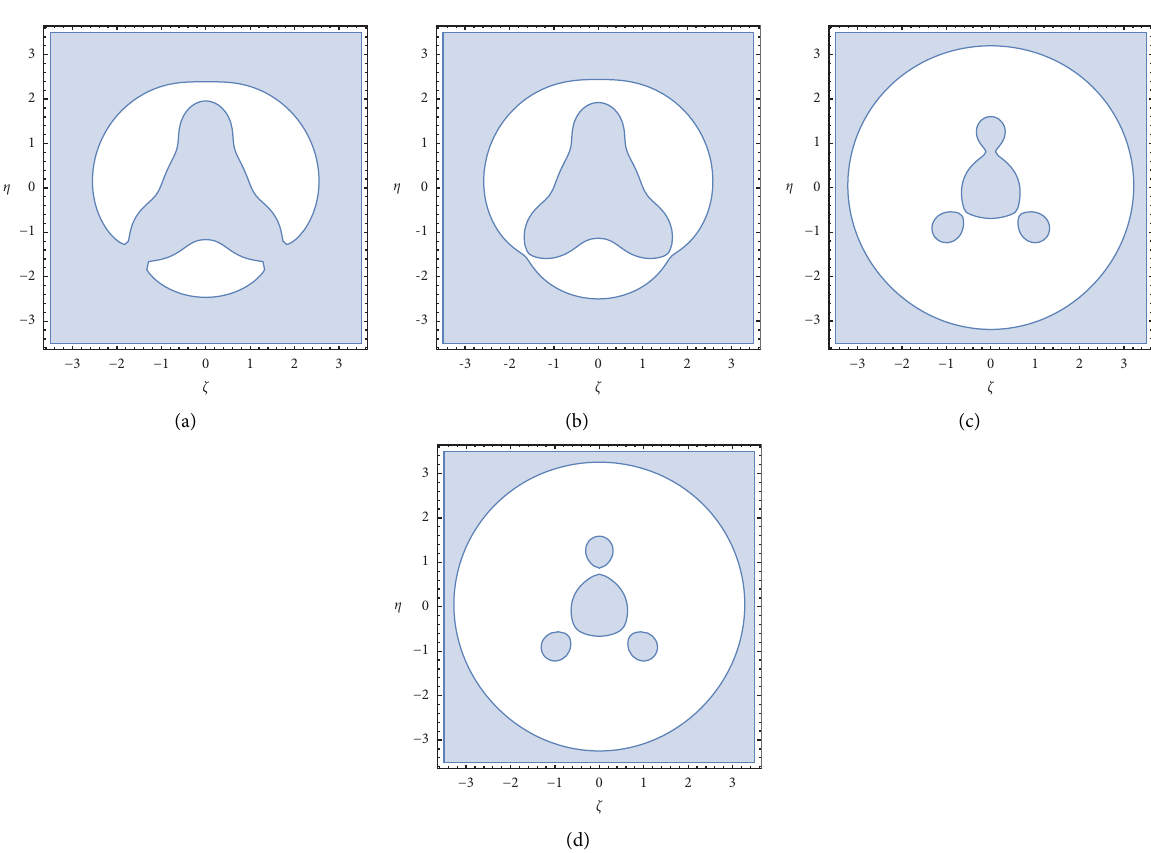
when μ � 0 . 01 (a) C � − 3 . 6, (b) C � − 3 . 65, (c) C � − 4 . 9. 5